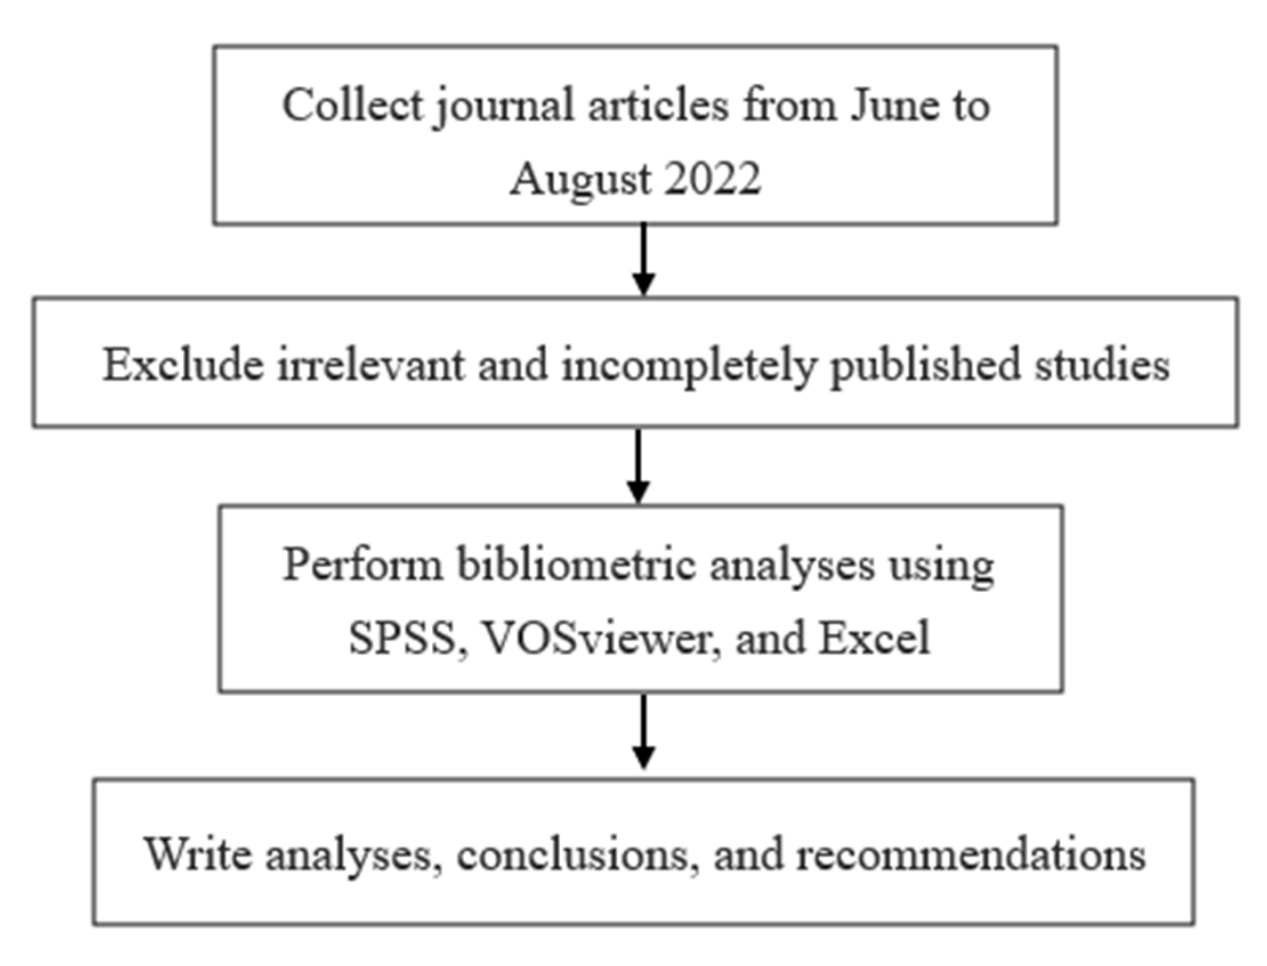
Figure 1. Research Figure 1. Research workflow.